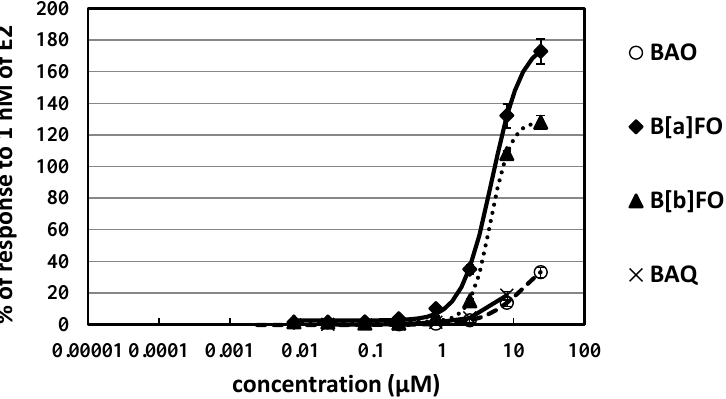
Figure 5. Dose–response curves of estrogenic activities for oxy-PAHs in 24 h exposure experiments with the ER-CALUX assay.